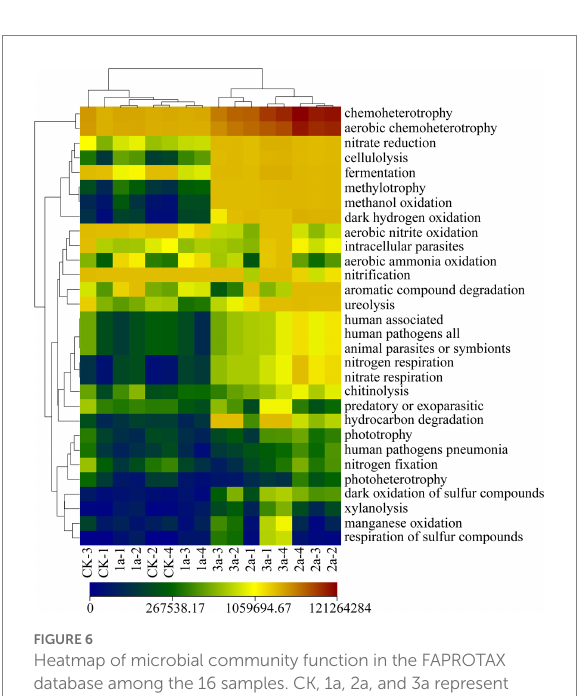
FIGURE 6 Heatmap of microbial community function in the FAPROTAX database among the 16 samples. CK, 1a, 2a, and 3a represent greenhouses consecutively planted for 0, 1, 2, and 3 years,